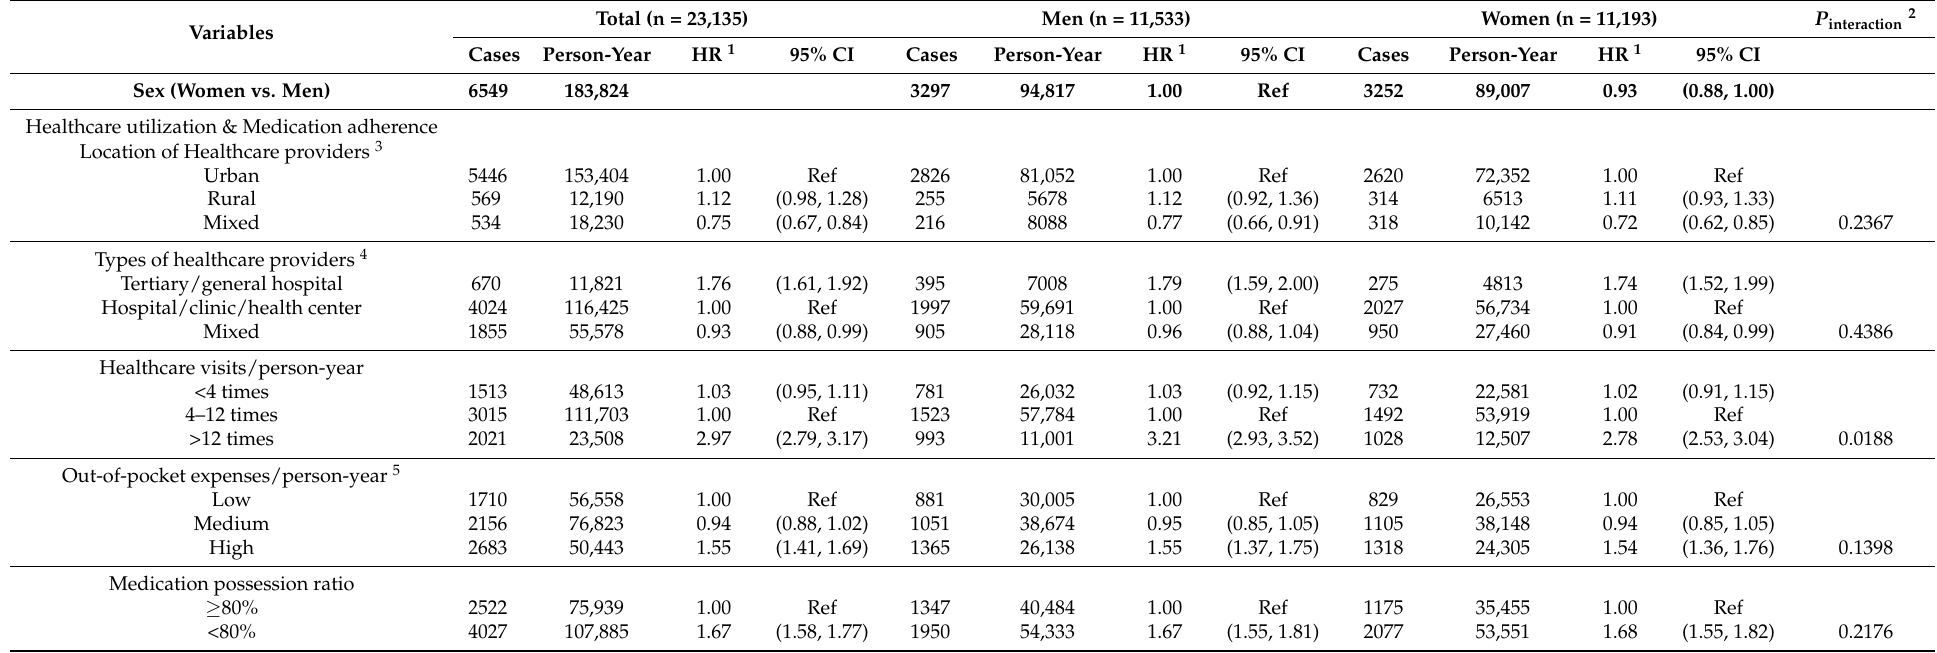
Table 3. Multivariate hazard ratios of the risk of ischemic heart disease according to healthcare utilization and medication adherence. Total (n = 23,135) Men (n = 11,533) Women (n = 11,193) P interaction 2 Variables Cases Person-Year HR 1 95% CI Cases Person-Year 95% CI Cases Person-Year 95% CI Sex (Women vs. Men)